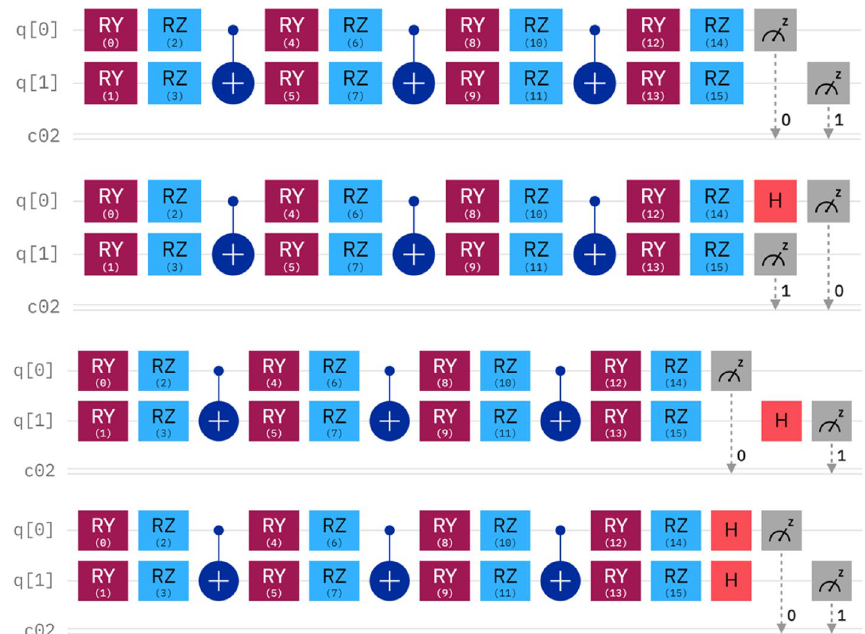
Fig. 4 The two-level circuits consisting of 8 R y and 8 R y rotation gates, 3 Controlled-X (or Controlled-NOT) gates, and 2 measurements on the two qubits, along with either 0 (top), 1 (middle two), or 2 (bottom) Hadamard gates. The values in parentheses represent the 16 variational parameters in the